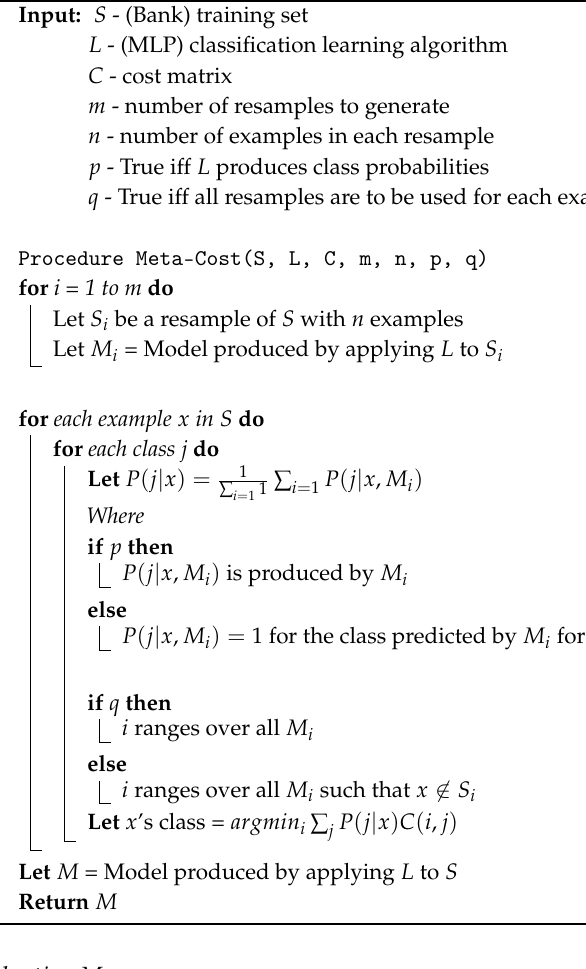
Algorithm 1: Meta-Cost Algorithm (Adapted from [44])